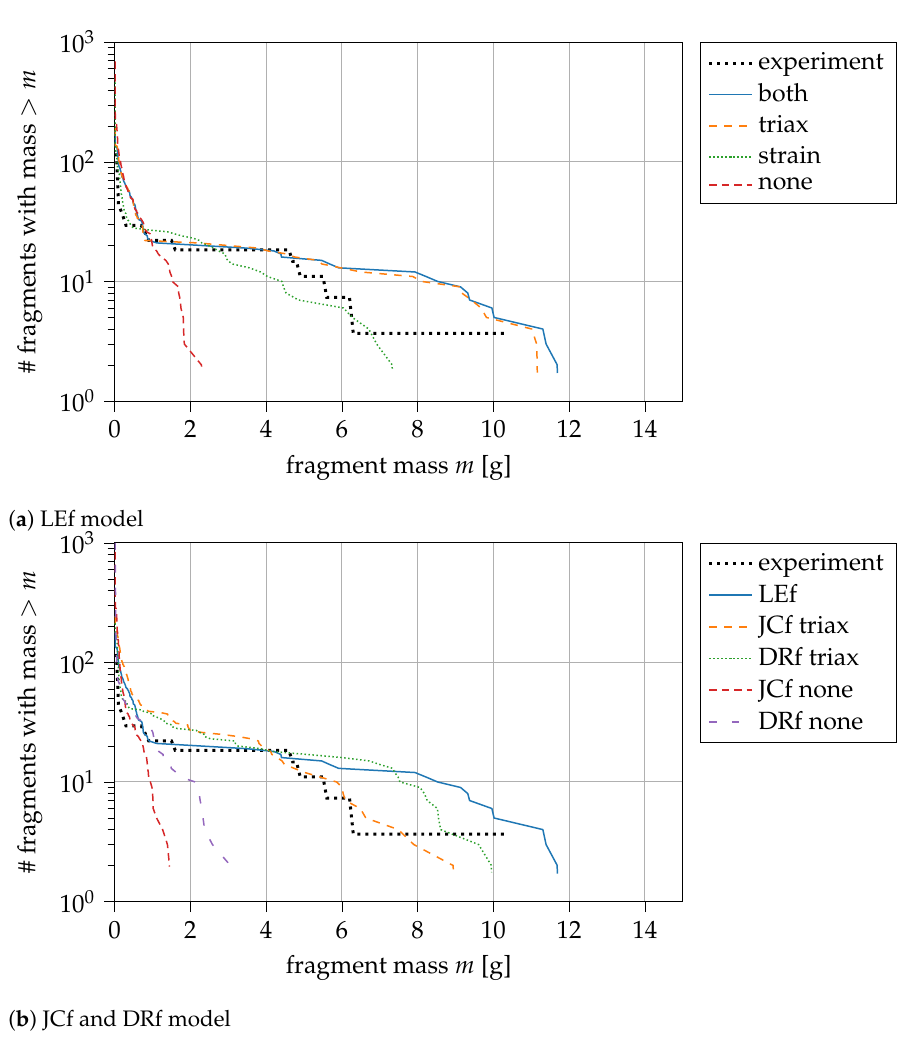
Figure 10. Modifications of the damage criterion for LEf, JCf, and DRf, results with the triaxiality cutoff criterion are much closer to the experiments for all criterias; experiment from